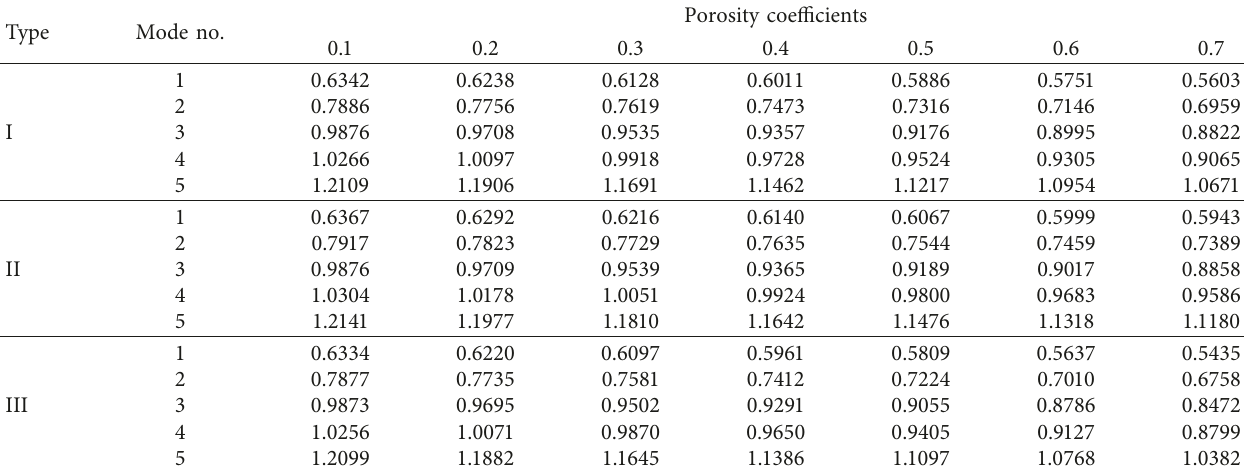
Table 9: Nondimensional frequency parameter Ω of porous rectangular plates with different porosity coefficients ( h / b � 0.2 and a / b � 0.5). Type Mode